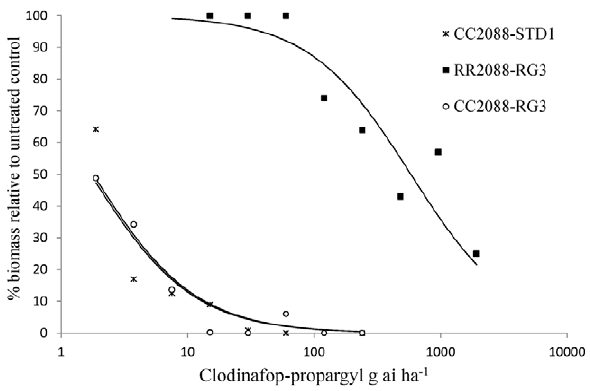
Figure 2. Clodinafop-propargyl whole plant dose response assay on wild and mutant 2088 genotypes.